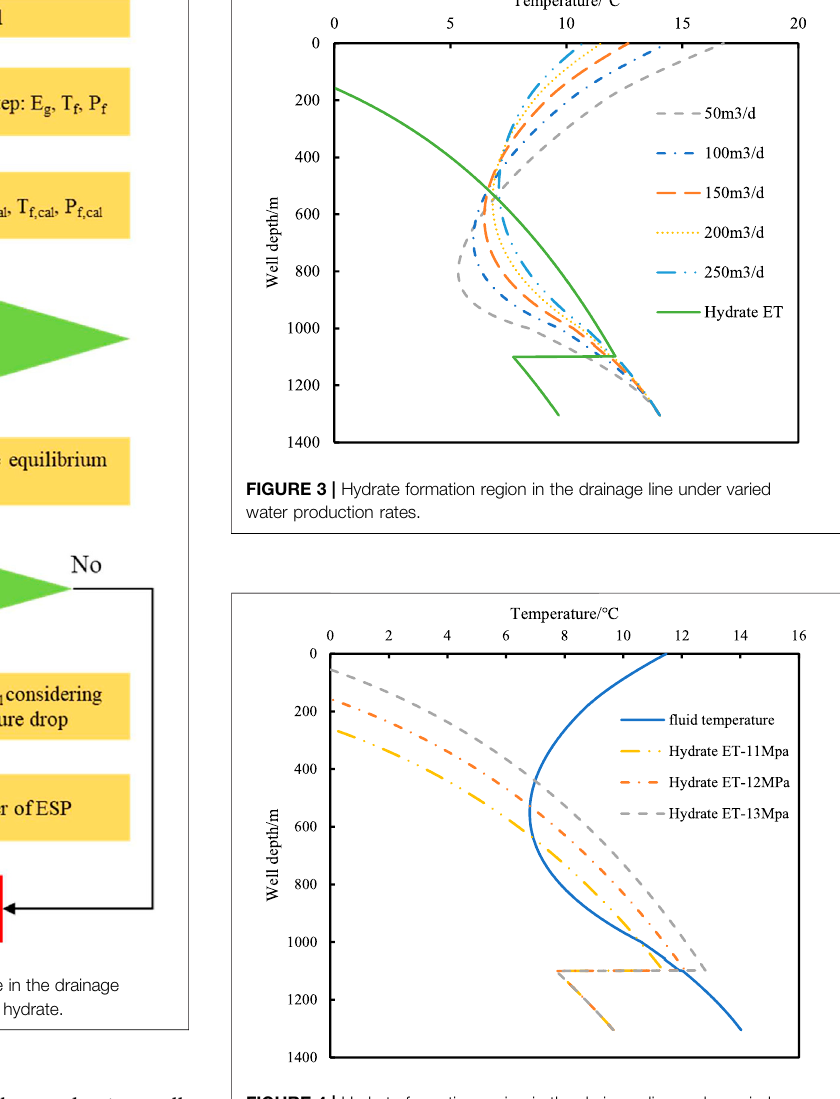
FIGURE 4 | Hydrate formation region in the drainage line under varied pump